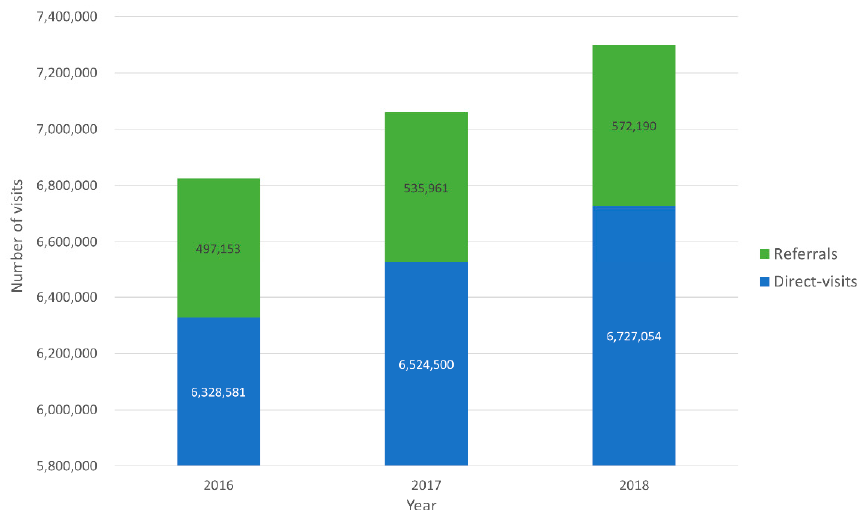
Figure 2. Trends in ED visits. The total number of ED visits increased from 6,844,321 to 7,305,451 and the proportion of referrals also increased from 497,153 (7.3%) to 572,190 (7.8%).